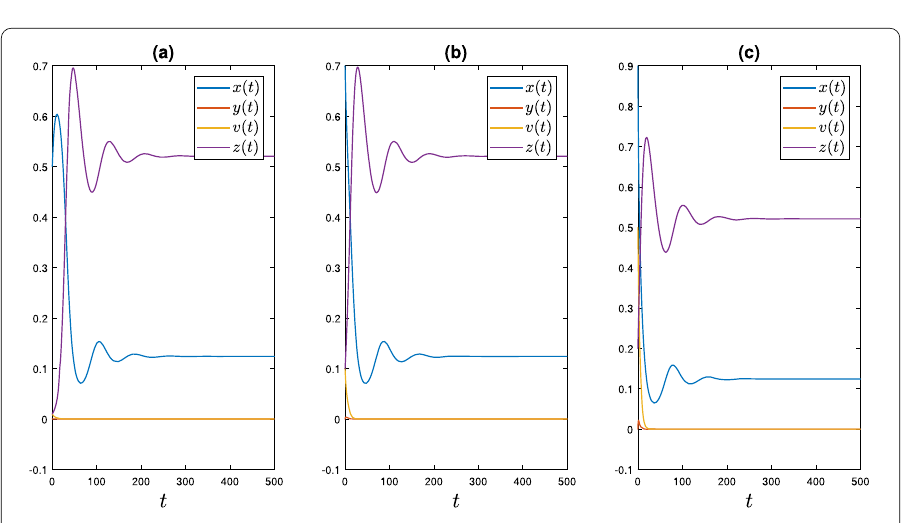
Figure 5 Numerical simulations of model (2) showing the time variation in the size of all relative populations of the model with various initial value. For these simulations, we used the following parameter values: r 1 = 0.36, a = 0.1, h 1 = 0.36, d 1 = 0.1278, c = 0.48, b = 2, h 2 = 0.16, e = 0.2, m 1 = 0.6, m 2 = 0.29, and n =